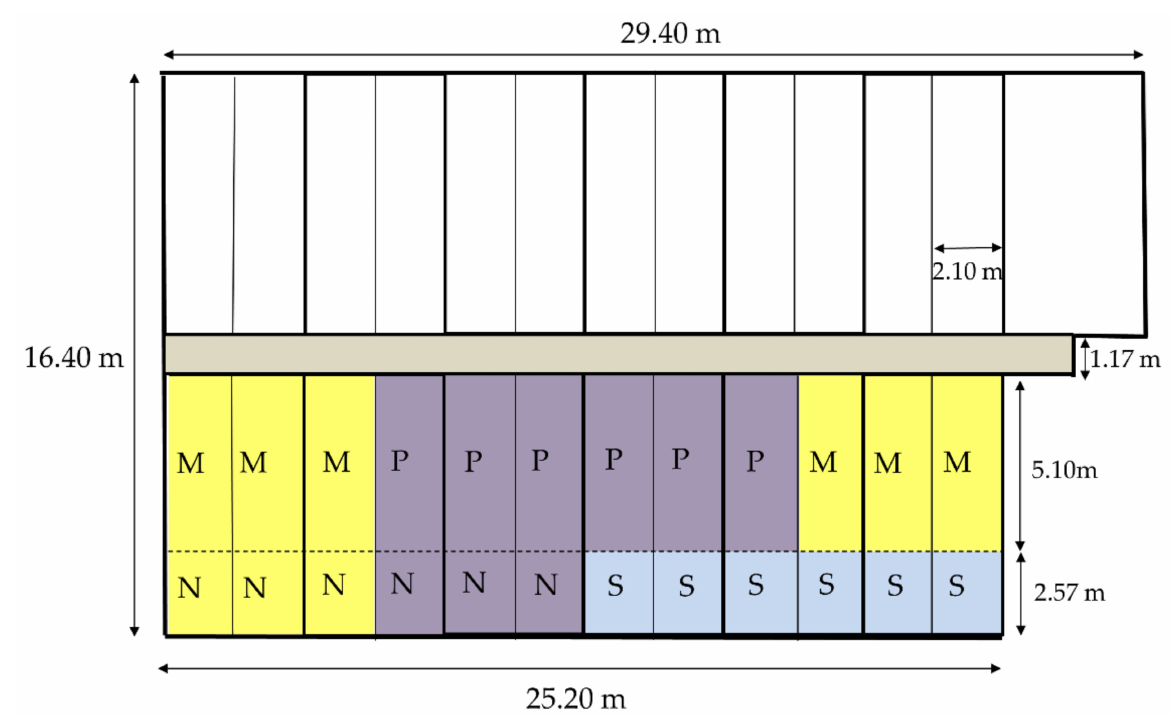
Figure 1. Planimetric map of experimental geese house. N: no swimming pool. S: swimming pool. M: mud floor. P: perforated plastic